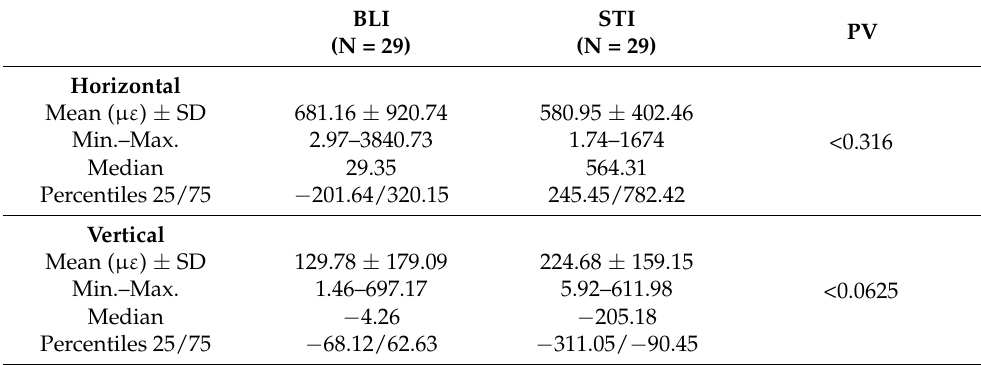
Table 2. Comparison of strain in the insertion phase between STI and BLI. Vertical µε is lower in both implants.